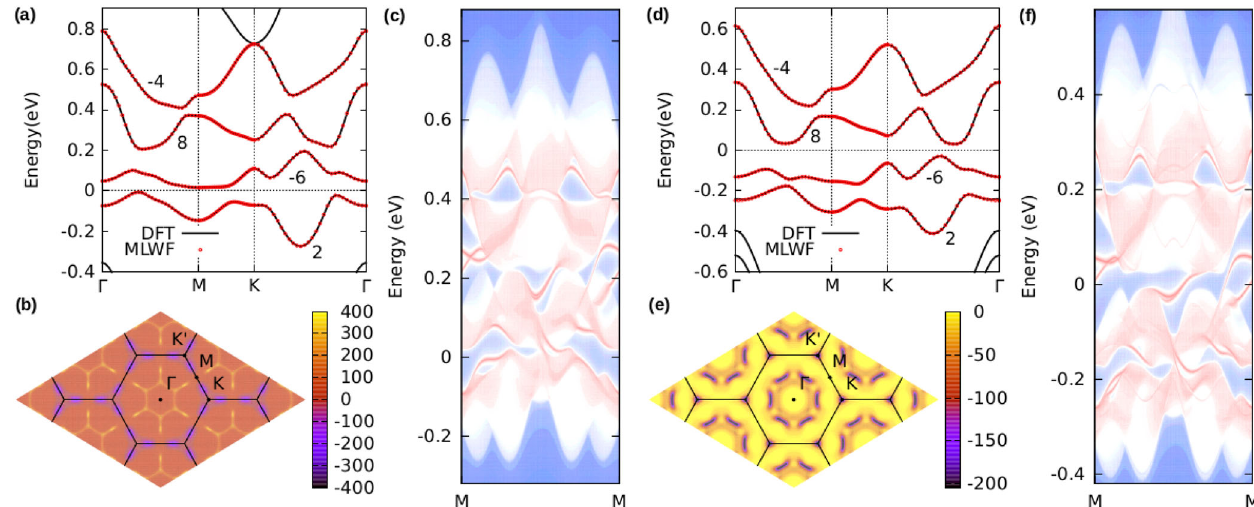
Fig. 3 Chern number, Berry curvature, and chiral edge modes. Cr e g bands manifold calculated by using DFT (black line) and Wannier function interpolation (red circle) under a one electron doping and d two electron doping per Cr 2 Si 2 Te 6 formula unit, respectively. Chern numbers for each band are also remarked. Berry curvature plot of the occupied Cr e g band in momentum space under b one electron doping and e two electron doping per formula unit, respectively. Unit of Berry curvature is Å 2 . Plot of chiral edge states along armchair direction under c one electron doping and f two electron doping per formula unit, respectively. Red lines indicate edge state components. Pink regions are bulk states, while the blue area corresponds to vacuum. All panels are drawn using data calculated by introducing SOC effect with ferromagnetic ordering to out-of-plane